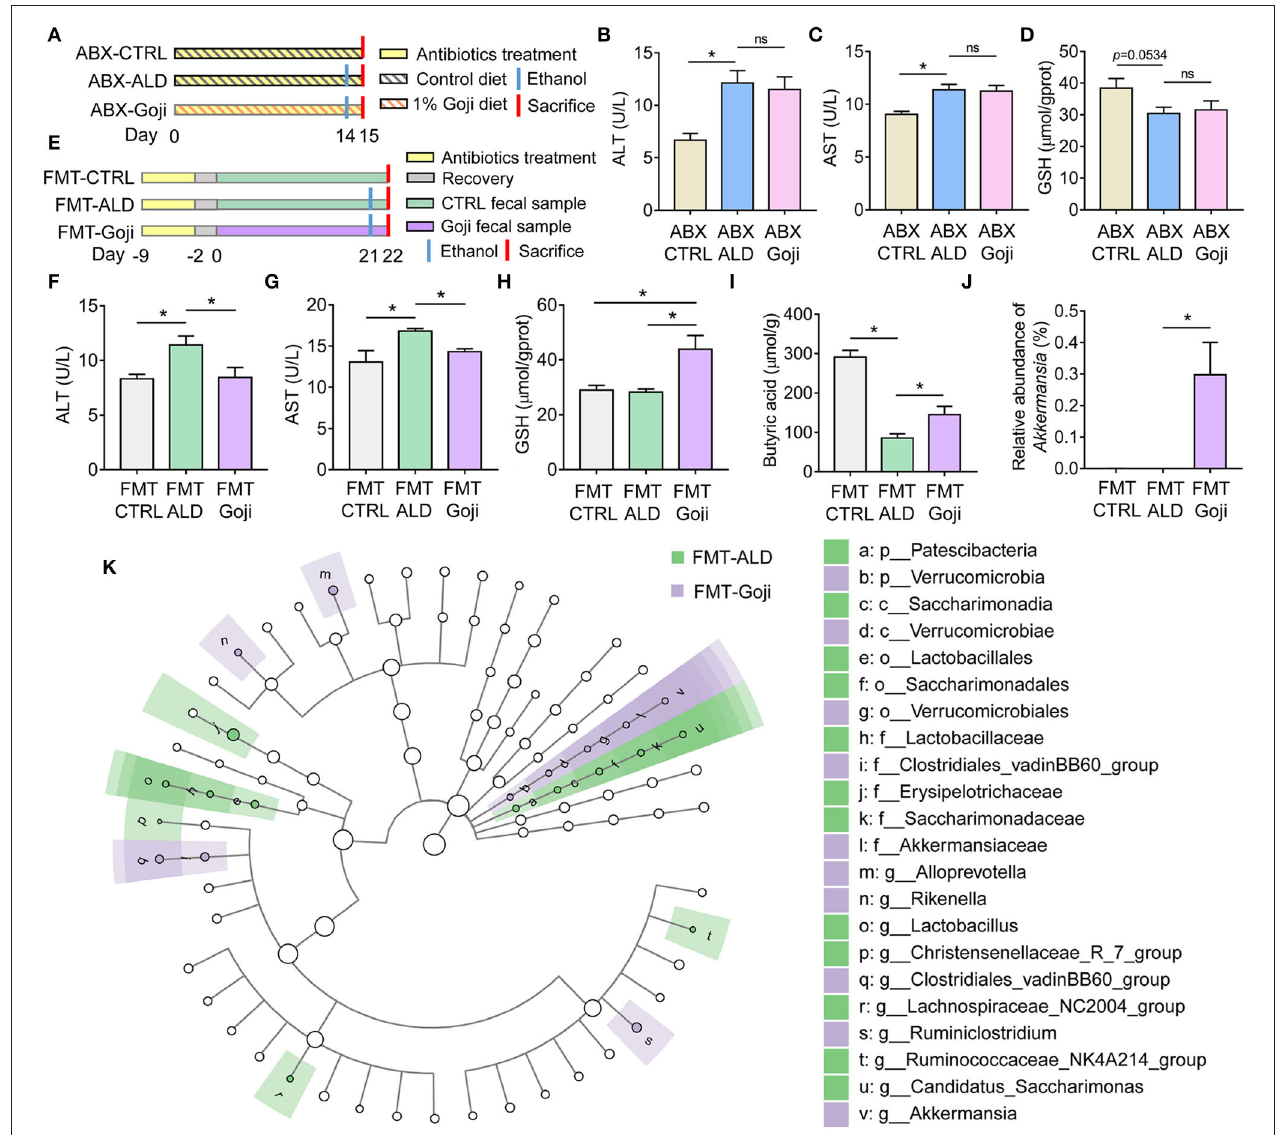
FIGURE 4 | The liver protective effect of Goji is dependent on gut microbiota. (A) ABX treatment experiment design. (B) the content of ALT in serum. (C) the content of AST in serum. (D) the content of GSH in liver tissue. (E) experiment design. Fecal samples from the CTRL group were transplanted to the pseudo-germ-free mice by antibiotics pretreatment and divided into groups: FMT-CTRL and FMT-ALD. The FMT-Goji group transplanted the fecal samples from the Goji pretreated mice. Both FMT-ALD and FMT-Goji groups were gavaged alcohol to induce alcohol liver injury. (F) the content of AST in serum. (G) the content of AST in serum. (H) the content of GSH in liver tissue. (I) quantification of cecal butyric acid. (J) relative abundance of Akkermansia . (K) significantly different taxa between FMT-ALD and FMT-Goji group analyzed by LEfSe analysis. Data are shown as mean ± SEM, and statistical significance is assessed by one-way ANOVA corrected for multiple comparison by Tukey’s test. * p -value <